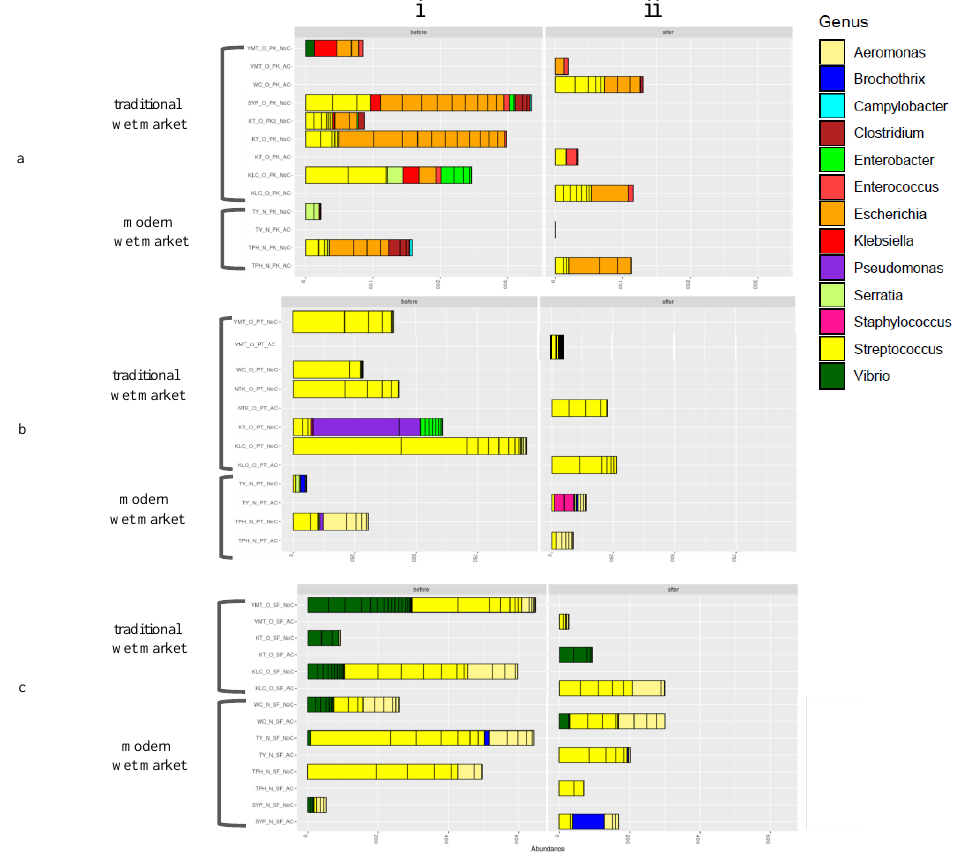
Figure 4. The relative genus-level abundance of bacteria in samples from wooden cutting boards used for di ff erent food groups: ( a ) pork, ( b ) poultry, and ( c ) seafood. Left (i) before cleaning, and (ii) after